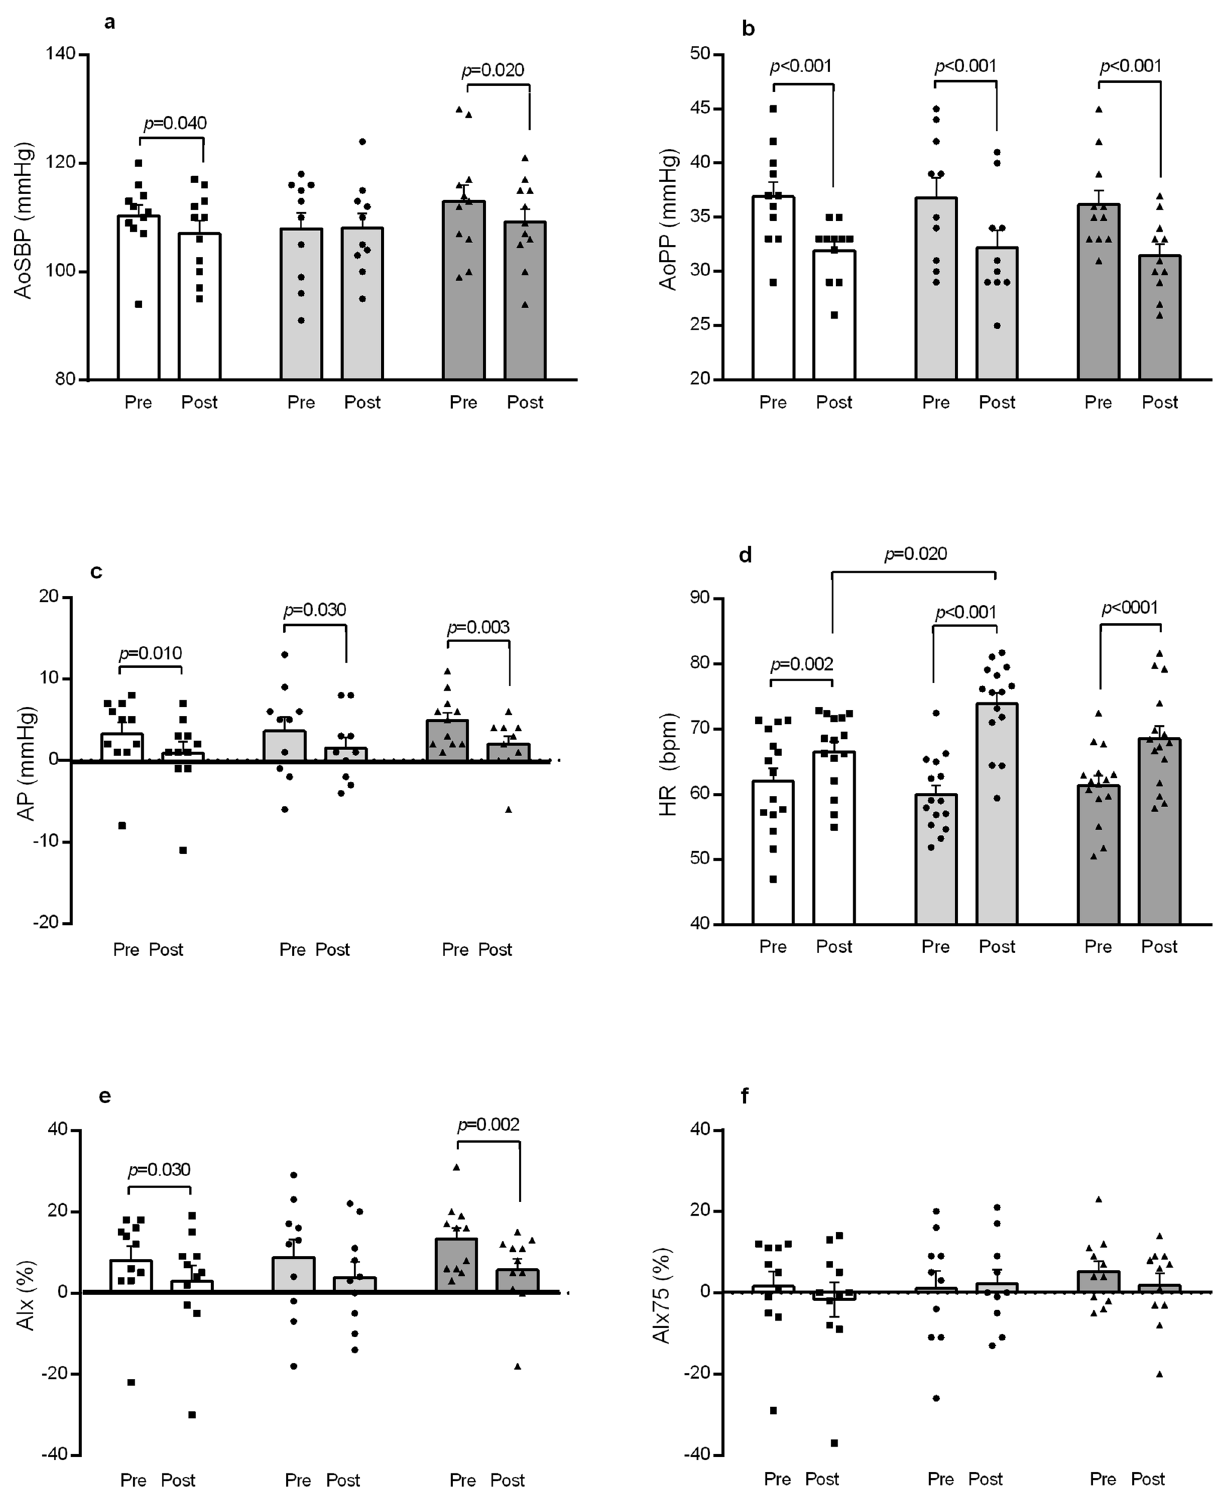
Figure 3. Pulse wave reflection outcomes before and after aerobic exercise (white bars), resistance exercise (light grey bars), and concurrent exercise (dark grey bars). AoSBP ( a ) aortic systolic blood pressure; aoPP ( b ) aortic pulse pressure; AP ( c ) augmented pressure; HR ( d ) heart rate; AIx ( e ) augmentation index; AIx75 ( f ) augmentation index normalized to 75 bpm. Data expressed as mean ±